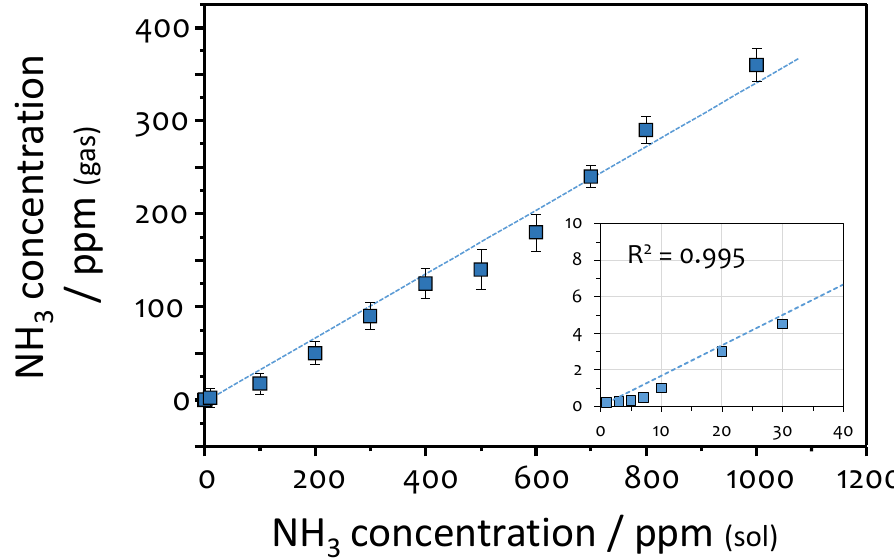
Figure 1. Dependence of the ammonia concentrations in the gas phase on the ammonia concentrations in the solution. The inset shows a narrower concentration range below 30 ppm (sol).